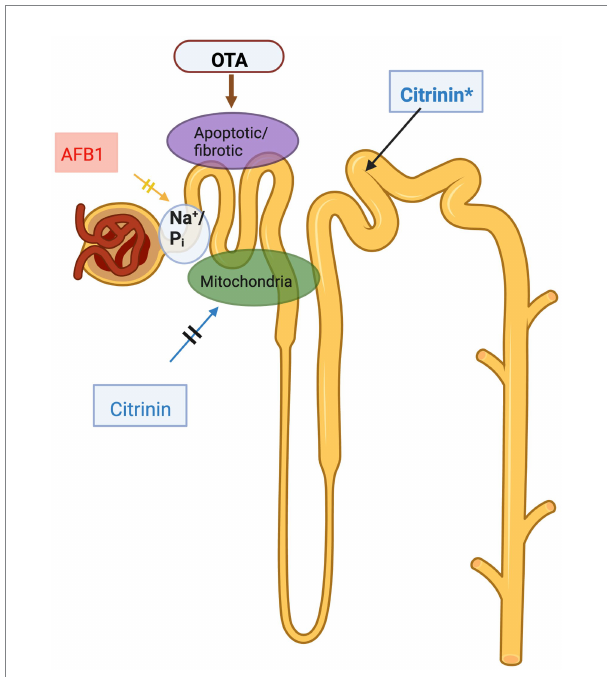
FIGURE 1 Mycotoxins affecting kidney, a schematic illustration. AFB1 dose dependently reduces Na + /P i co-transport in proximal tubule epithelial cells, reducing reabsorption of inorganic phosphates; OTA also targets the proximal tubule, causing cell death and profibrotic effects; citrinin targets the proximal tubule in many species, such as dogs, pigs, rabbits and rats but in mice citrinin targets the distal tubule (indicated by asterisk in the figure). The figure was created with